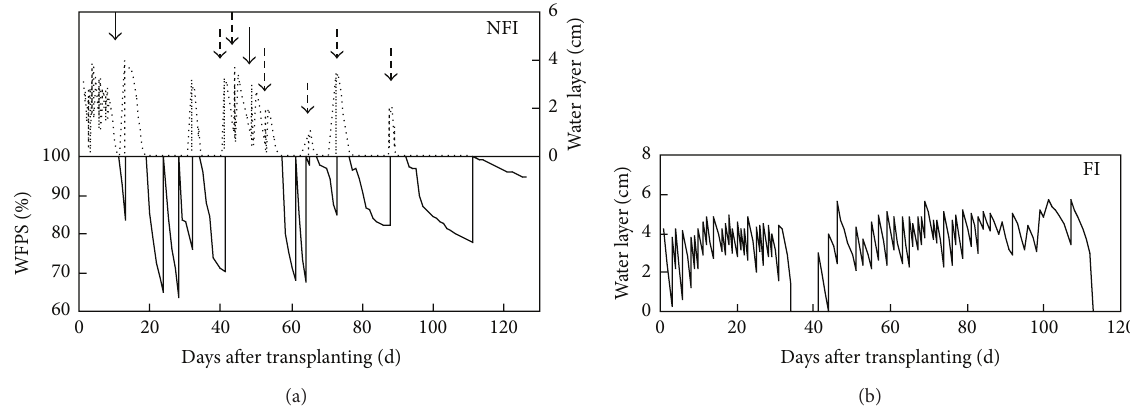
Figure 1: Water depth and soil moisture in FI and NFI rice fields (solid and dashed arrows denote irrigations for fertilizer and pesticides application in NFI rice fields).